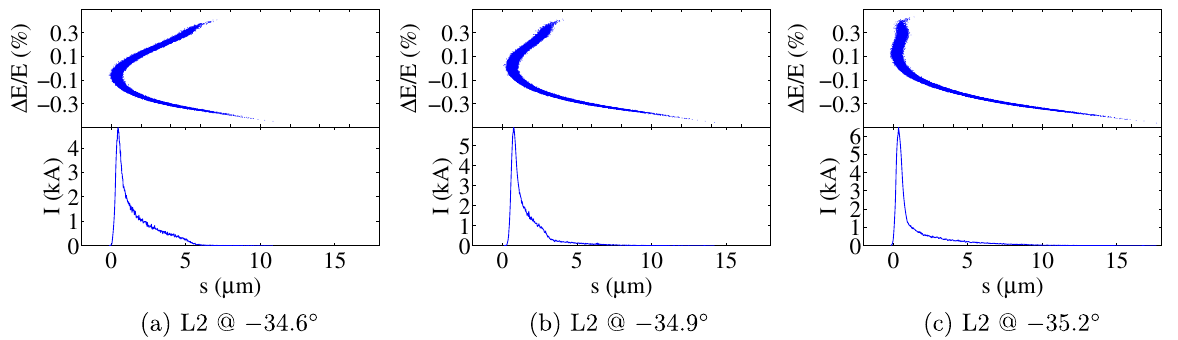
FIG. 2. L I T RACK simulations for electron bunch distribution in the longitudinal phase space (upper) and its current profile (lower) at the LCLS undulator entrance. The L2 rf phase is adjusted from − 34 . 6 ° (a) to − 35 . 2 ° (c), which rotates the longitudinal phase space while maintaining a relatively constant current spike. The L1S rf phase is − 27 °, and the L1X phase and amplitude are − 180 ° and 15 MV, respectively. For the phase space and current plots in this figure and throughout the paper, the bunch head is to